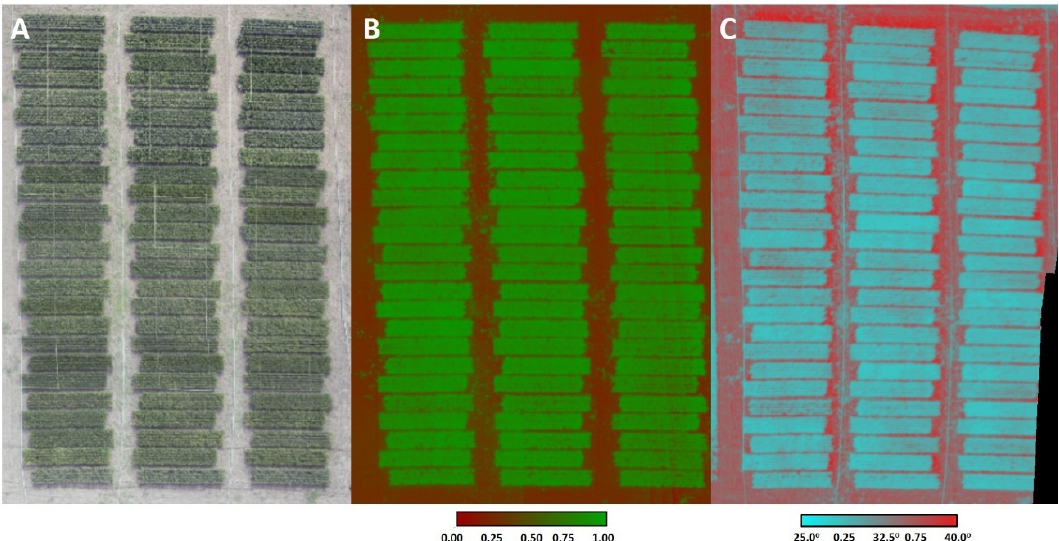
Figure 2. Red–green–blue (RGB) ( A ), false-color normalized di ff erence vegetation index (NDVI) ( B ), and false-color thermal ( C ) orthomosaic examples corresponding to the late-planting trial during the heading stage at the third sampling visit. Both the multispectral and thermal mosaics have been given false colors: in the former, low NDVI values have been colored red and high values colored green, in the latter, warmer temperature values have been colored red and the colder values colored blue